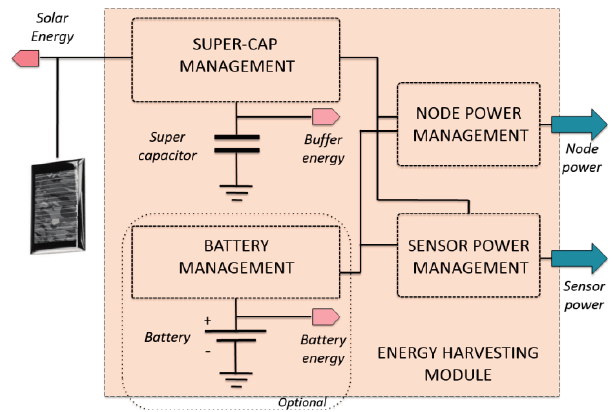
Figure 7. Energy harvesting circuit block